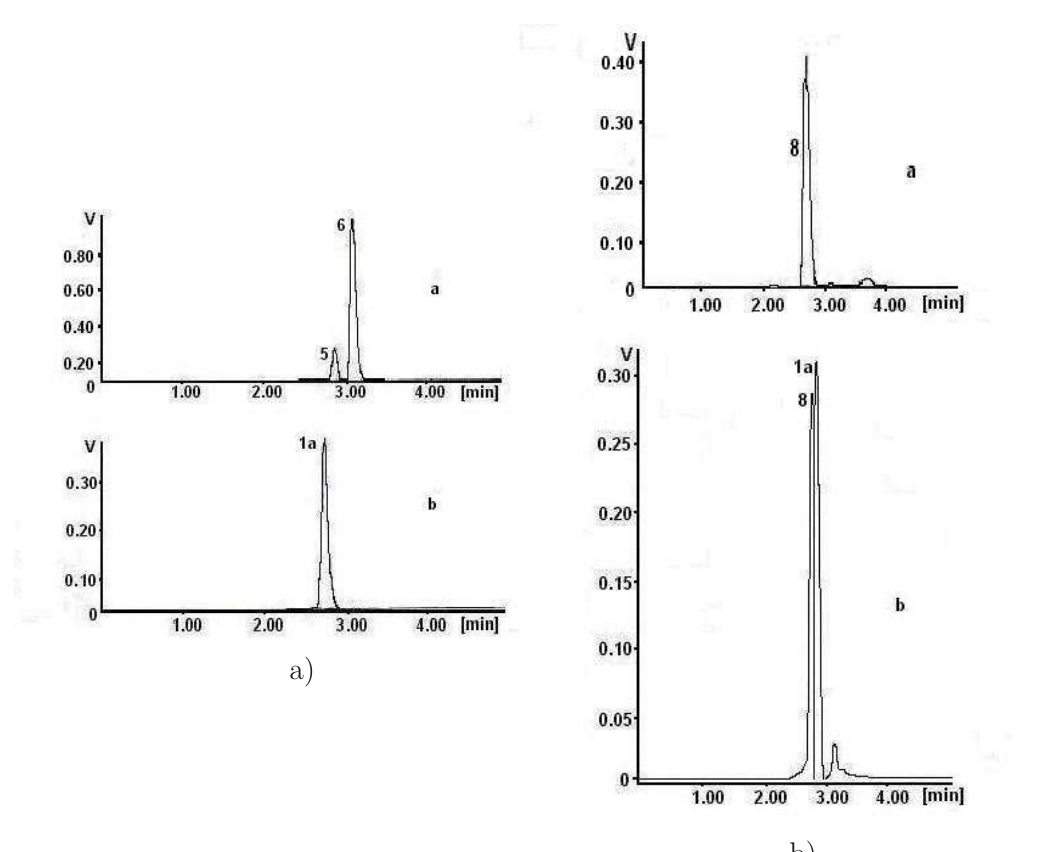
Fig. 2 HPLC monitoring of the 2-(diethylaminomethyl)phenyl bromide ( 1a )